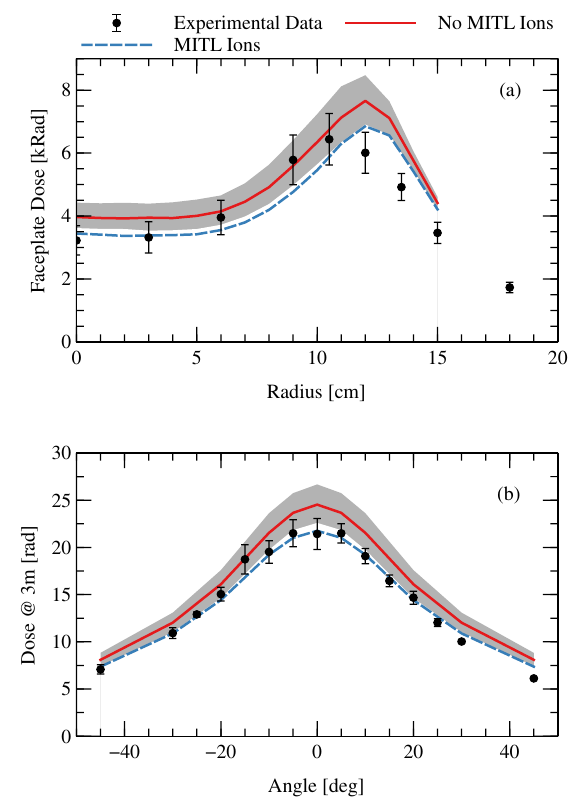
FIG. 10. Comparison of measured (points) and simulated (curves) doses from simulation Case 0 and Case M4, in (a) the near field and (b) the far field. The main effect of adding upstream ion emission in the MITL is a reduction in the dose by 10% – 15%. The shapes of (a) the faceplate dose distribution and (b) the far-field dose distribution are mostly